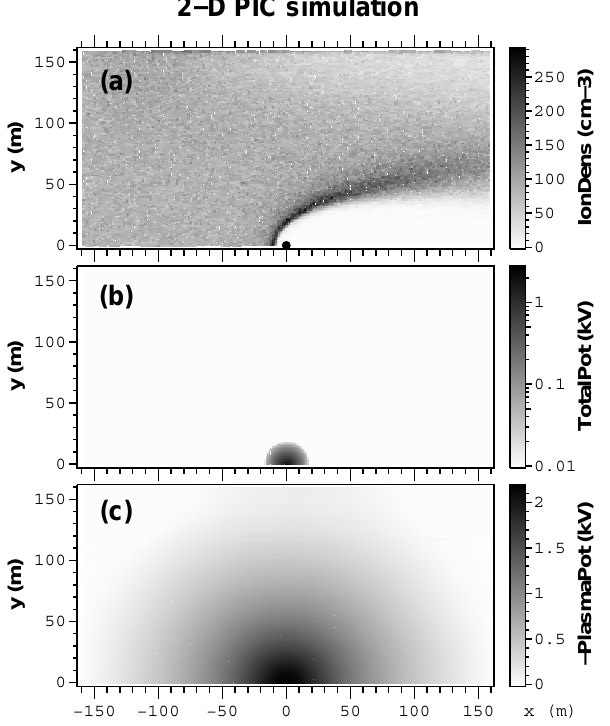
Fig. 4. One-dimensional potential profiles along subsolar line taken from the 2-D PIC simulation at t = 20ms. Dashed line (topmost curve) is the source potential profile of the wire. Line marked with dots (bottommost curve) is the plasma potential from the simula- tion. Solid line in the middle is actually two lines very close to- gether, one is the total potential (plasma plus source) and the other is the function (V 0 / 2 ) ln ( 1 + (r 0 /r) 2 )/ ln (r 0 /r w )) + C (Eq. 2) with r w = 10 µ m, r 0 = 19 . 97m and C =− 10 . 68V fitted to the first one. Notice logarithmic scale in horizontal axis. Table 1. Effect of grid spacing 1x , box length L x , timestep 1t and number of ions per cell in solar wind N cell on Method 1 and 2 for per unit length dF 1 /dz and F 2 /dz , respectively. Last line corresponds to the standard